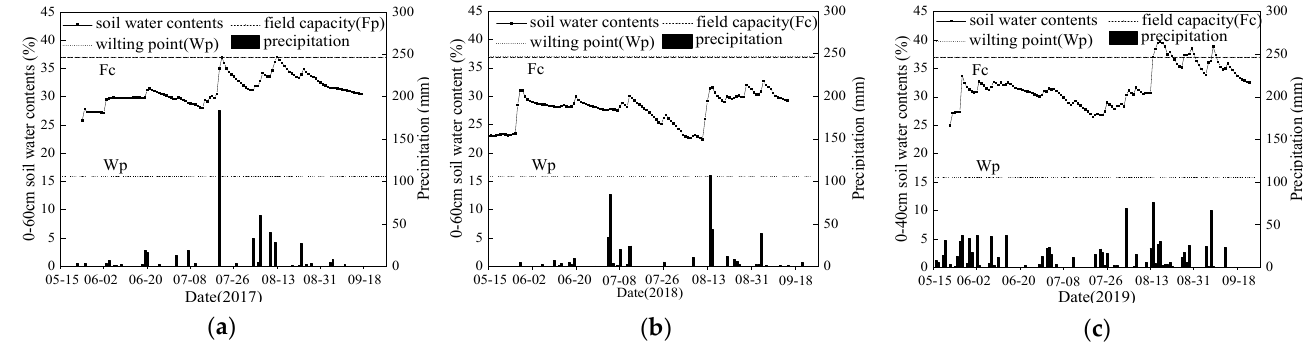
Figure 2. Precipitations and soil water contents changing during maize growing season in Changchun during three years: ( a ) 2017; ( b ) 2018; ( c ) 2019.